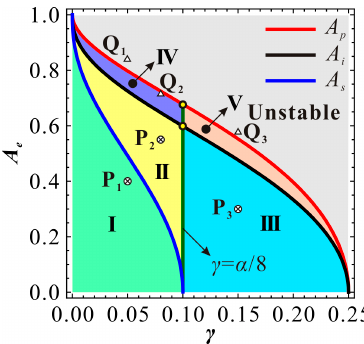
Figure 6. A nondimensional zoning diagram depicting the extreme amplitude versus nondimensional DC voltage for α = 0.8, µ = 0.005 and δ = 100 (P 1 , P 2 , and P 3 correspond to extreme amplitudes with low energy. The corresponding Q 1 , Q 2 , and Q 3 have high-energy extreme amplitudes).